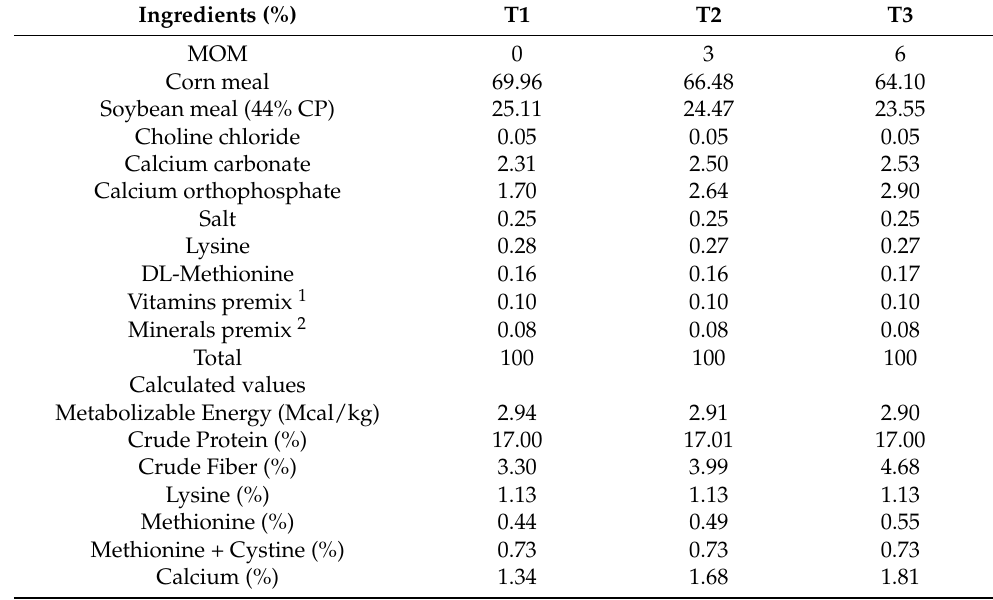
Table 2. Composition, calculated values, and chemical analysis of the experimental diets (in